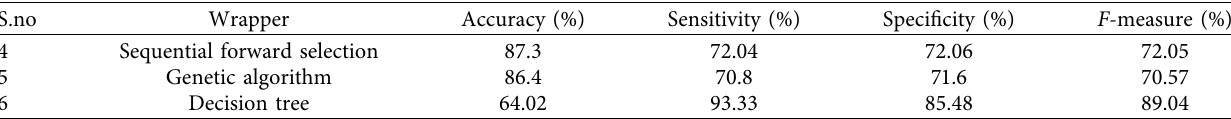
Table 8: Top 3 Wrapper approaches performance for gene microarray